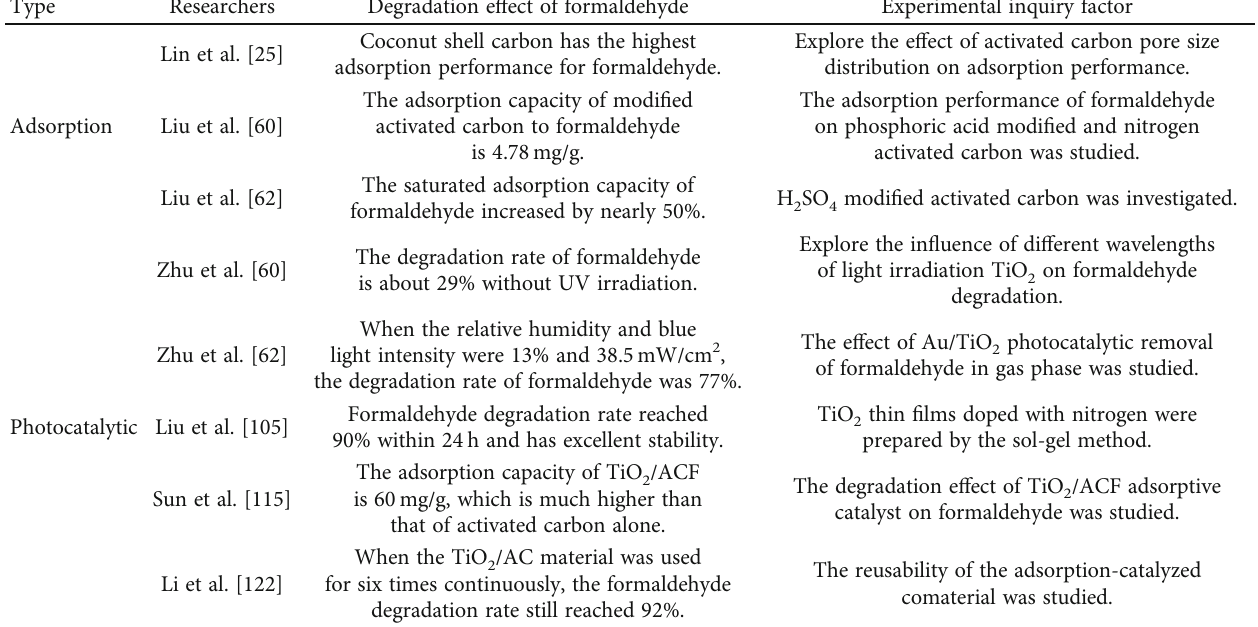
Table 6: Some previous studies on adsorption and